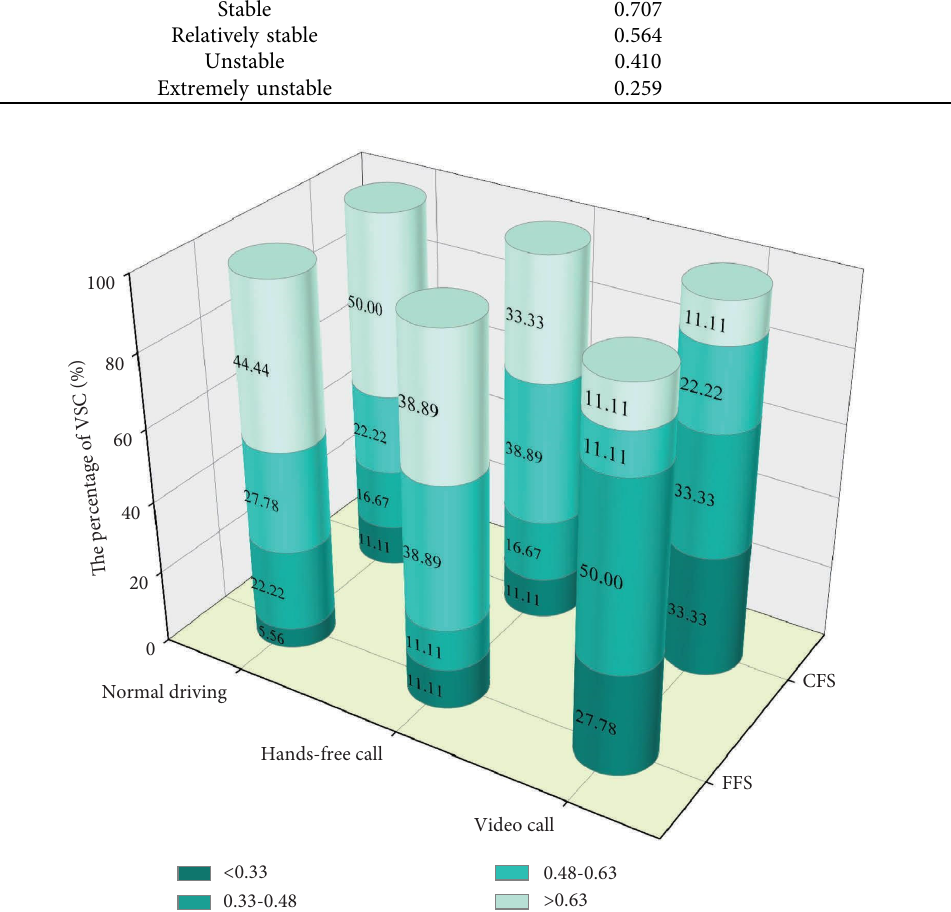
Figure 9: Percentage of VSC in each interval for diferent trafc conditions and driving